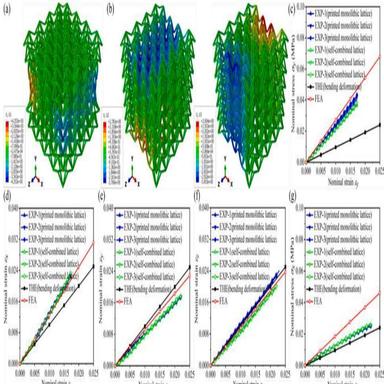
Experimental verifications of the assembly method, transverse deformation distribution of 3D DVH lattice when compressed in (a) y- and (b) x-directions, experimental (EXP), numerial (FEA) and theoretical (THE) results of (c) σy − εy, (d) εx − εy, (e) εy − εx, (f) εz − εx and (g) σx − εx curves of self-combined lattice and printed monolithic lattice with PA12.